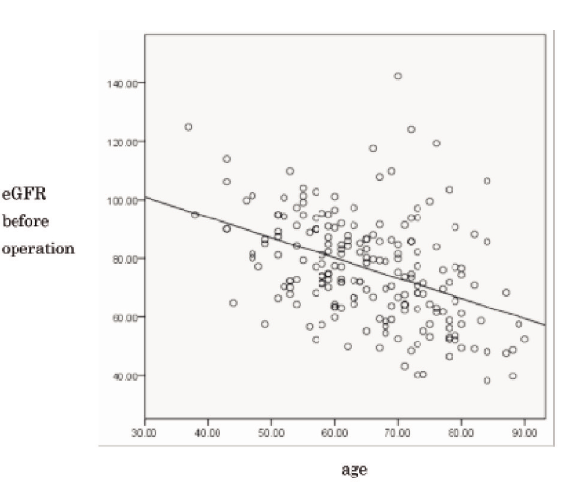
Relationship between age and pre-operative renal Fig. 2: function (R=-0.420, p<0.001). eGFR, estimated glomerular filtration rate.